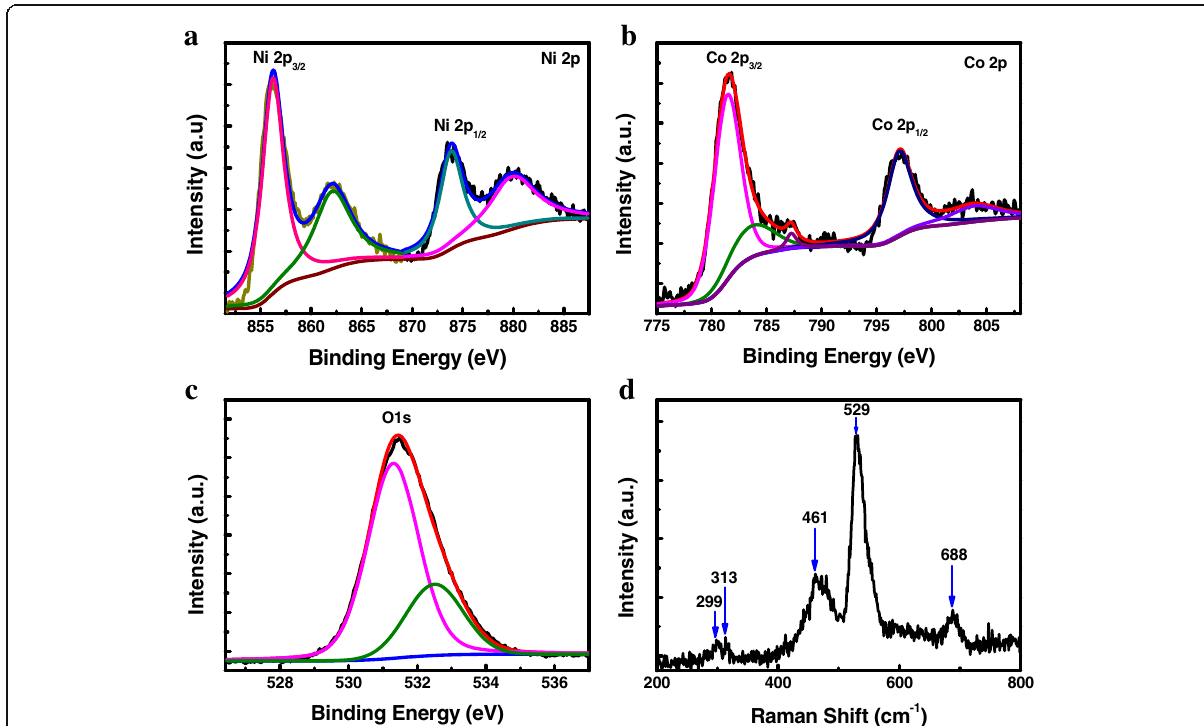
Fig. 2 Chemical states of bonded element characterizations of the products. a – c XPS spectra of Ni 2p, Co 2p, and O 1s. d The Raman spectrum of the amorphous Co-Ni